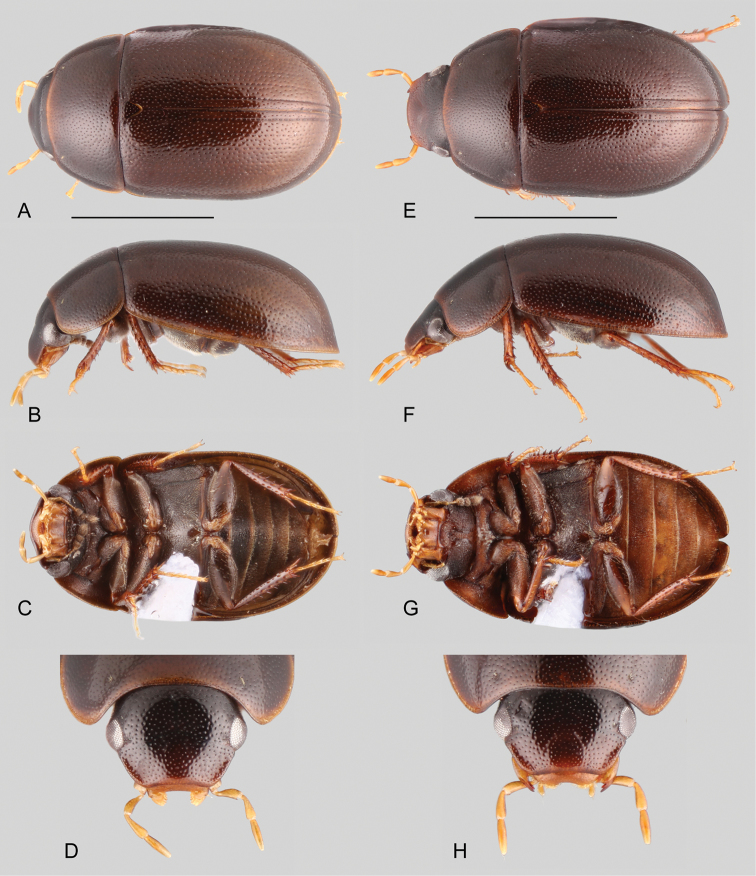
Habitus of Primocerus spp.: A–DPrimocerusmaipure: A dorsal view B lateral view C ventral view D head, dorsal view. E–HPrimoceruspijiguaense: E dorsal view F lateral view G ventral view H head, dorsal view. Scale bars: 1 mm.